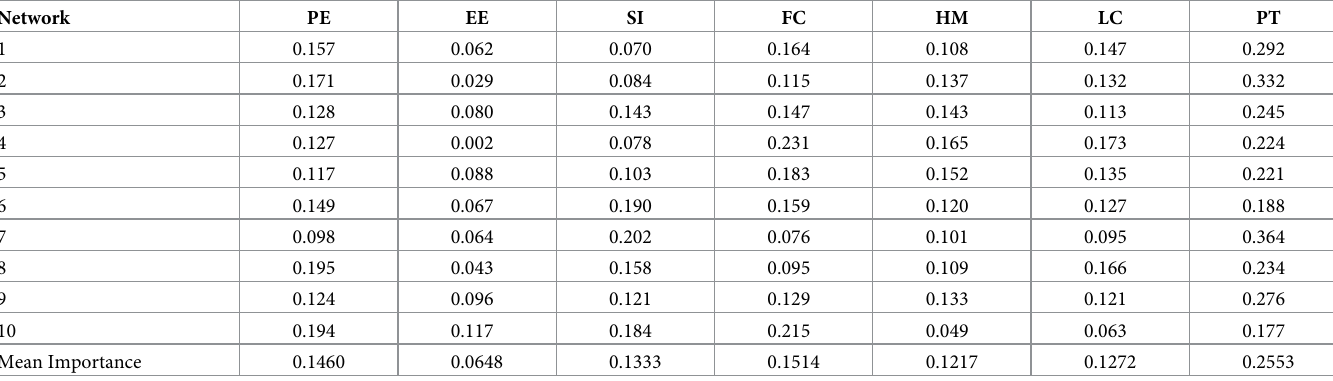
Table 9. Sensitivity analysis.